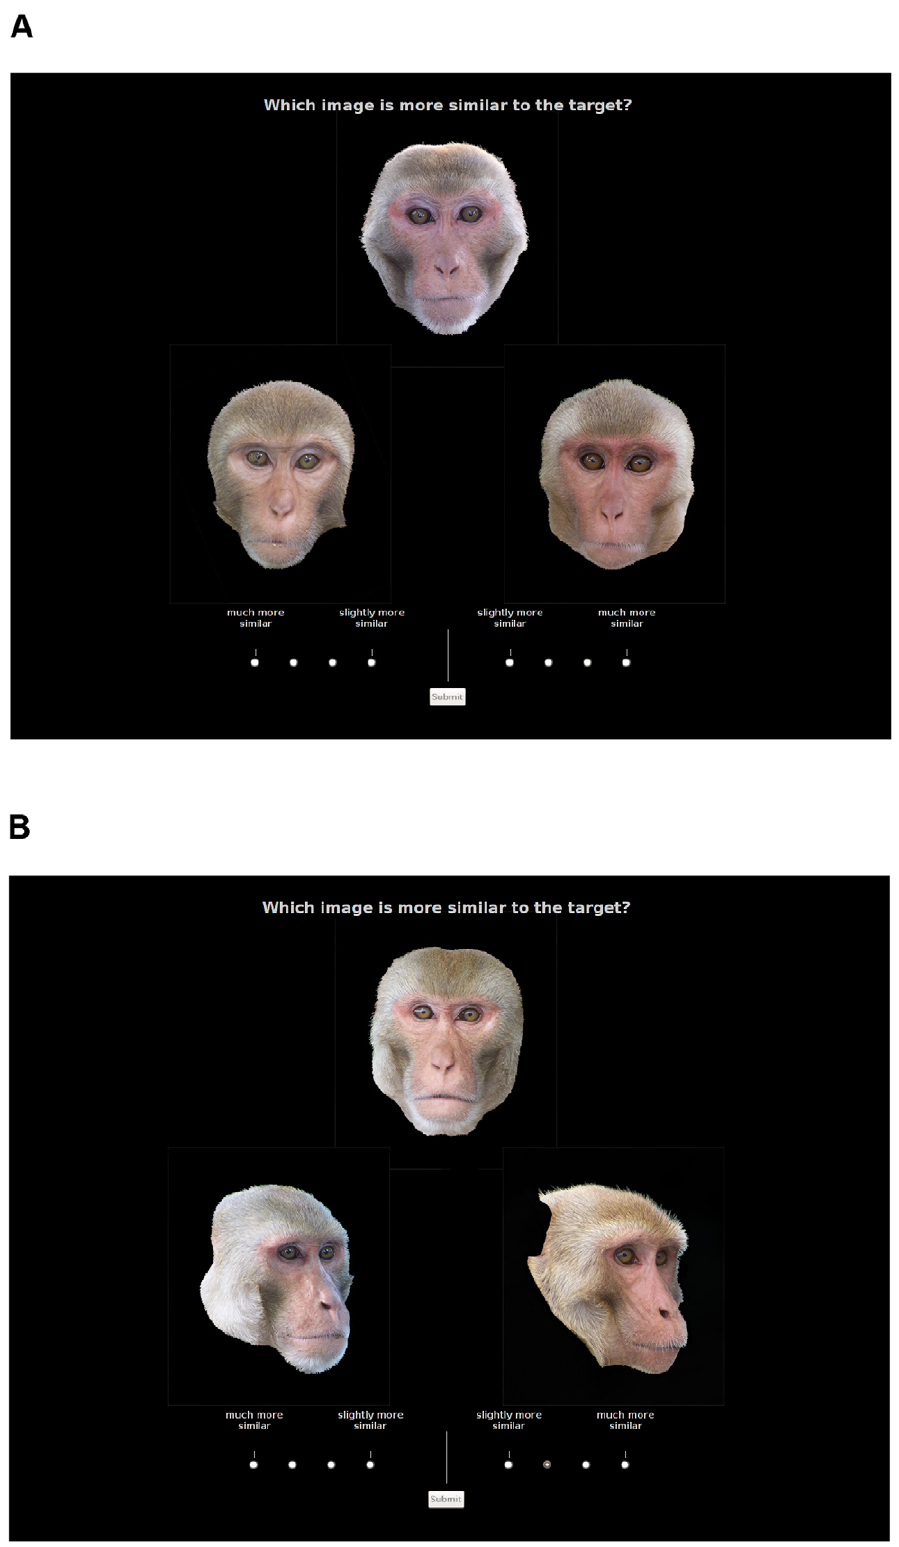
Figure 1. Examples of (A) kin discrimination and (B) individual discrimination trials. The target is displayed uppermost, with two alternative matches placed below. (A) A paternal line mixed-sex kin discrimination trial, with the father displayed uppermost. In this case the correct choice (daughter) is the lower-right image. (B) A male-male individual discrimination trial, in which the target and lower-left images are of the same animal.